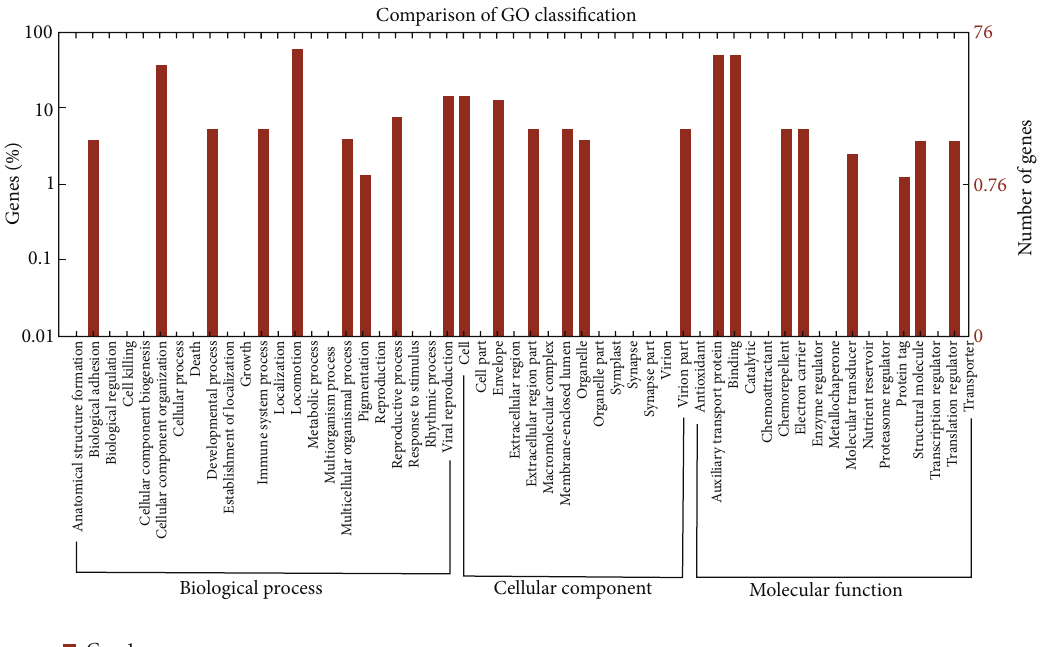
Figure 4: Histogram presentation of gene ontology classification between A (C0, TR130348) and B (C24, TR130349). The results are summarized in three main categories: biological process, cellular component, and molecular function. The right 𝑦 -axis indicates the number of genes in a category. The left 𝑦 -axis indicates the percentage of a specific category of genes in that main category.